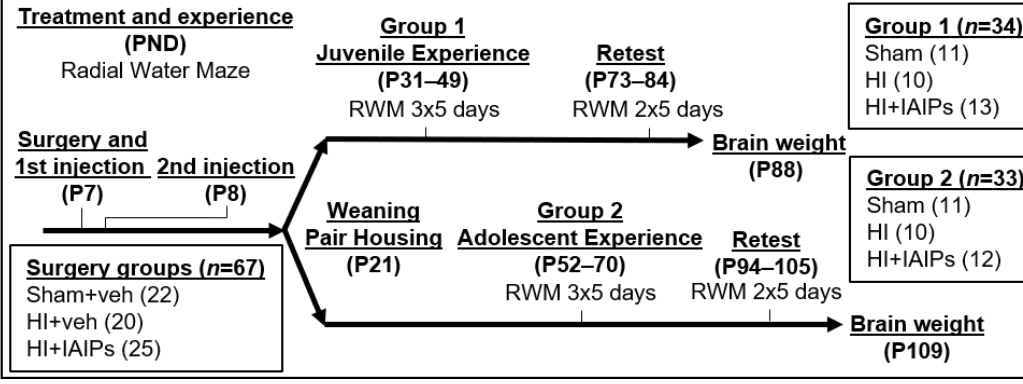
Figure 1. Timeline for surgery, exposure to Hypoxic-Ischemic (HI), Inter-alpha Inhibitor Proteins (IAIP) treatment, Radial Water Maze (RWM) experience, and tissue collection by post-natal day (P#). Subject numbers post-surgery separated into experience groups (Group 1 = Juvenile, Group 2 = Adolescent) are indicated in boxes. All subjects were male rats.